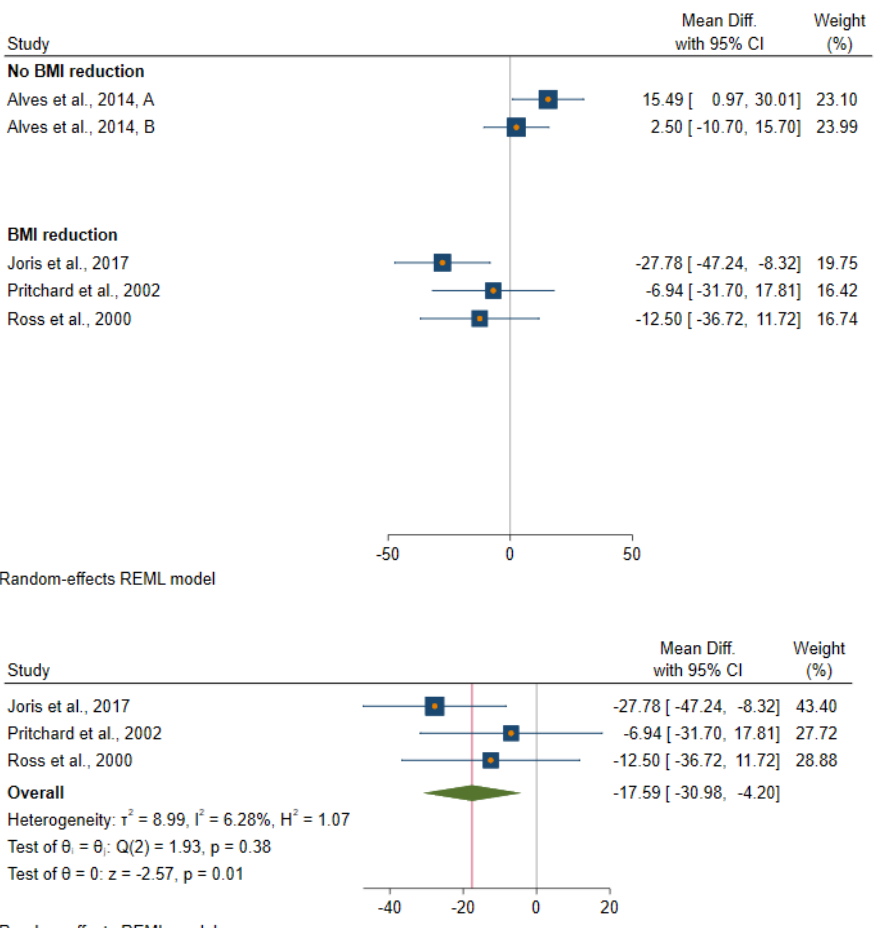
Figure 3. Forest plot of studies which evaluated an effect of a reduction in body fatness on fasting glucose levels.